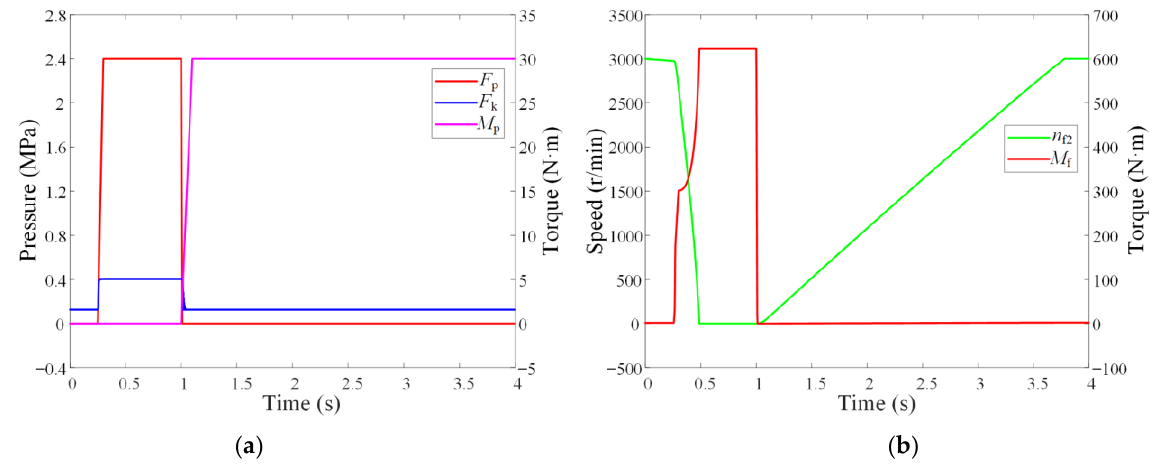
Figure 4. Variations of dynamic parameters in a four-second working cycle. ( a ) Control oil pressure, return spring force, and motor torque. ( b ) Rotating speed of friction disc and friction torque.